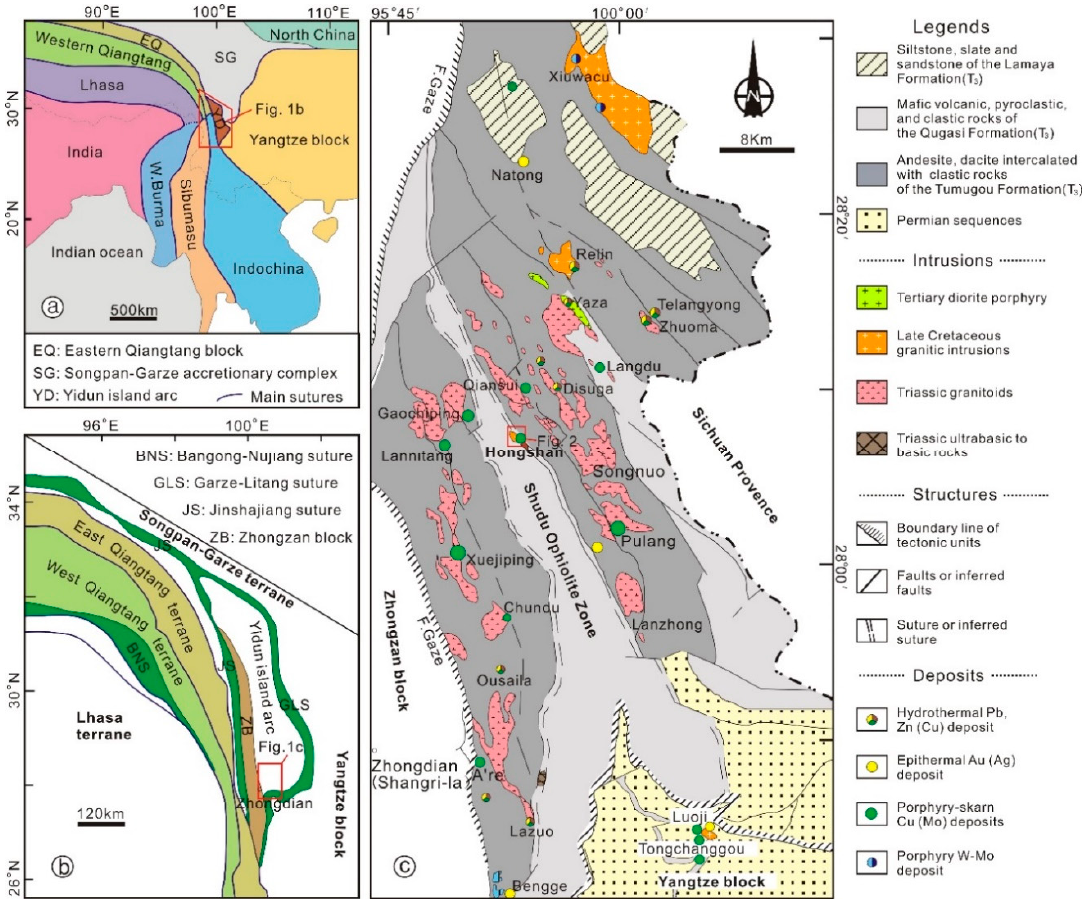
Figure 1. ( a ) Tectonic map sketch showing the distribution of principal continental blocks and sutures of Southeast Asia. The location and outline of the Yidun island arc are indicated. ( b ) Tectonic framework of the Sanjiang Tethyan domain and location of the southern Yidun arc. ( c ) Geological map showing the distribution of porphyry and skarn deposits in the southern Yidun arc. Modified from Zu et al. and Deng et al. [1,17].